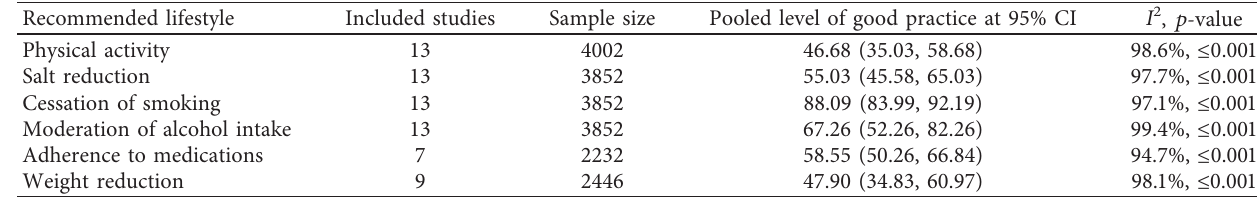
Table 3: Pooled levels of adherence to the recommended self-care practice among hypertensive patients in Ethiopia. Recommended